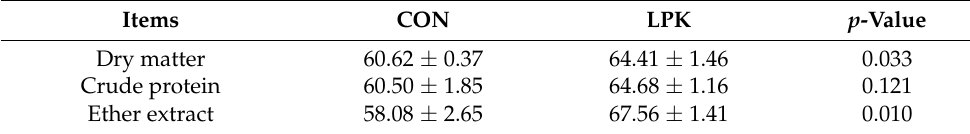
Table 3. Effects of live Pichia kudriavzevii on nutrient digestibility of Hu sheep 1